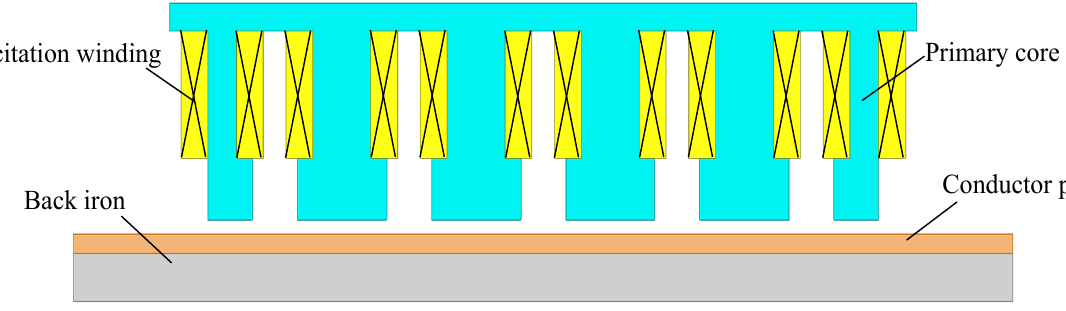
Figure 16. ( a ) Field line distribution and ( b ) the magnetic flux density map.